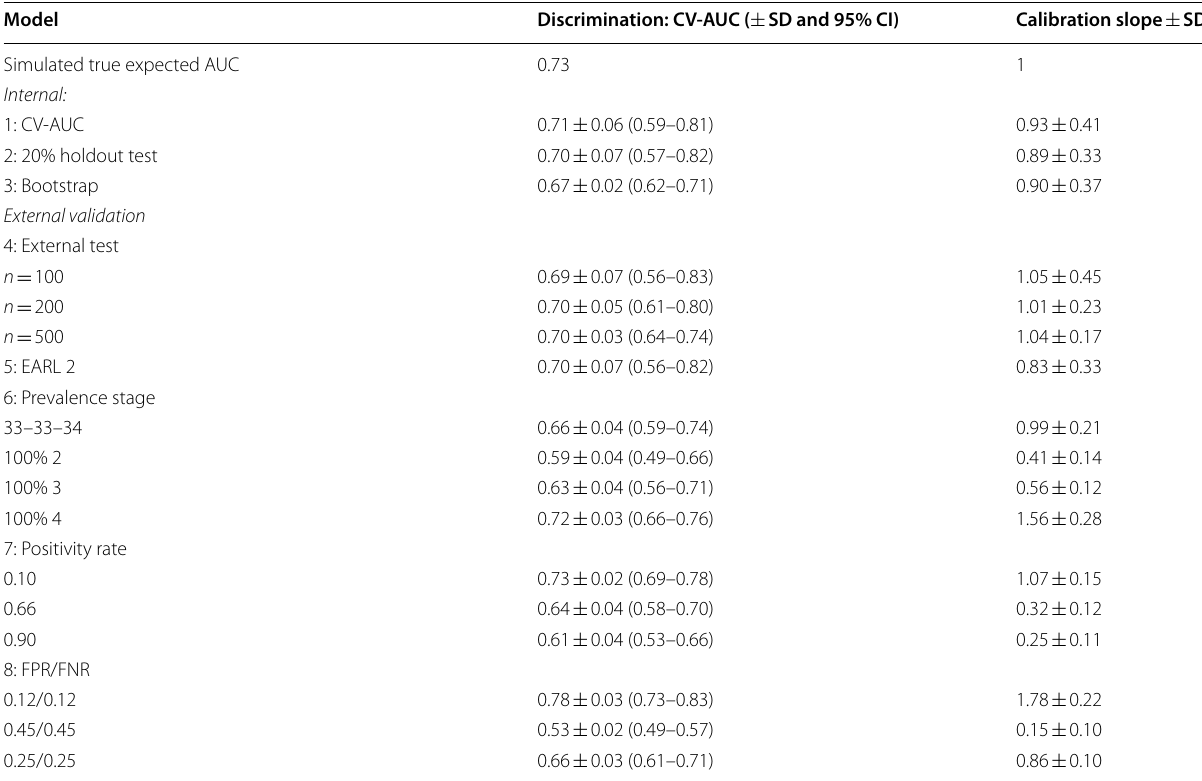
Table 2 model performance expressed as CV-AUC and confidence interval and the standard deviation of models